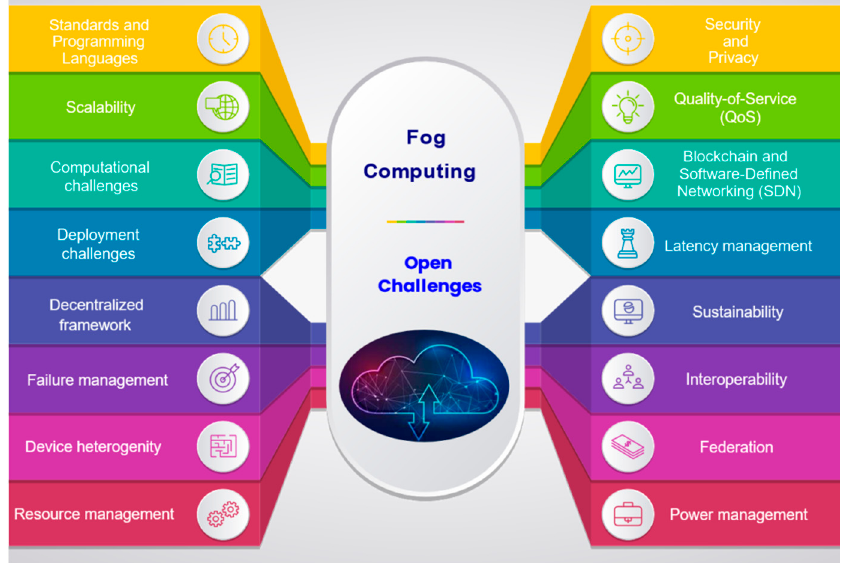
Figure 13. Fog computing—open challenges.